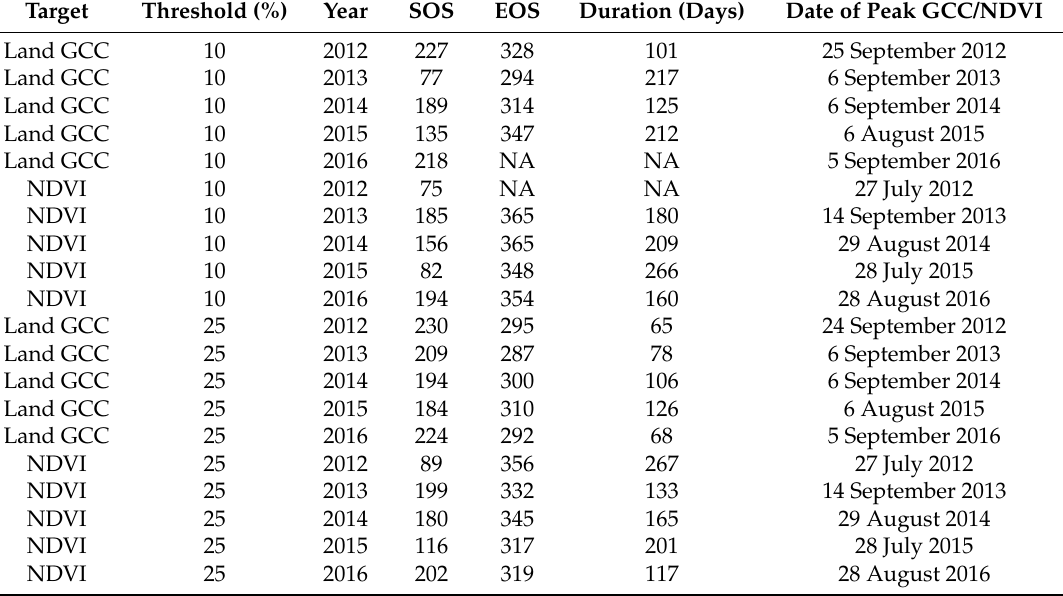
Table A2. Dates for growing season start (SOS), end (EOS), and peak for landscape (Land) ROI from phenocam GCC and MODIS NDVI time series using the Timesat program with 10% and 25% seasonal amplitude